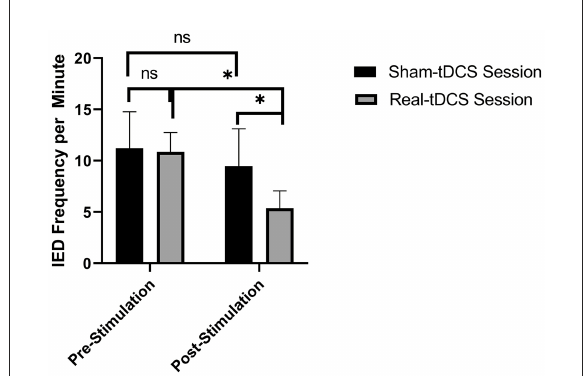
FIGURE2 Real transcranial direct current (tDCS) decreased the interictal discharges (IEDs) frequency per minute from (10.86 ± 3.74) prestimulation to (5.37 ± 3.38) post-stimulation [ p = 0.045] and from (9.46 ± 2.74) after sham tDCS to (5.37 ± 3.38) after real tDCS [ p = 0.018]. n.s.: not statistically significant, i.e., p > 0.05. * means statistically significant with a p < 0.05.